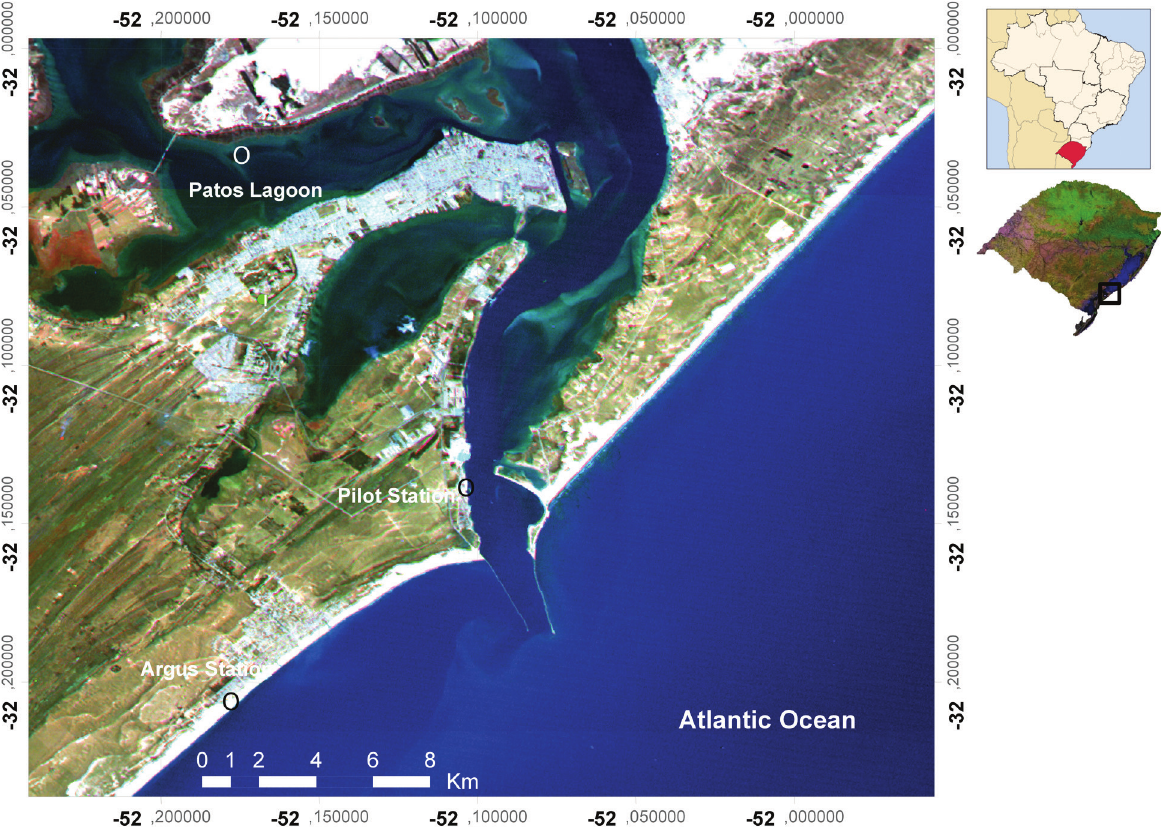
Figure 2 - Study area centered around the Argus station on Querência Beach, which is within Cassino Beach. The Pilot Station where the metrological data were collected is shown. The background image is from Landsat TM (2006). The two insets show (top) the country of Brazil with the RS state highlighted; and (bottom) RS with the study area marked as a